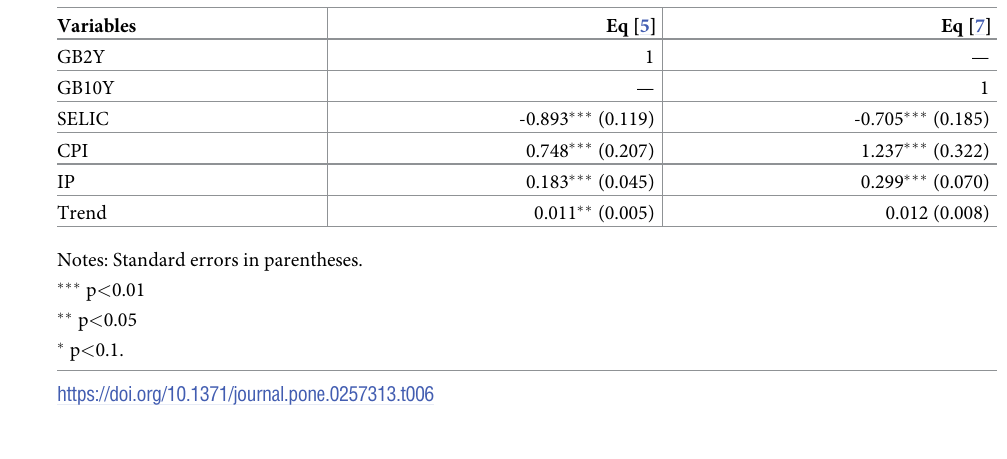
Table 6. Long-run relationship under alternative